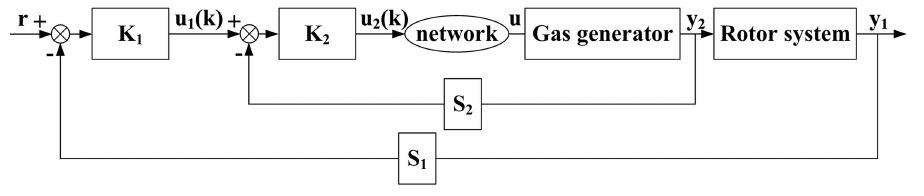
Fig 2. Block diagram of the NCCS